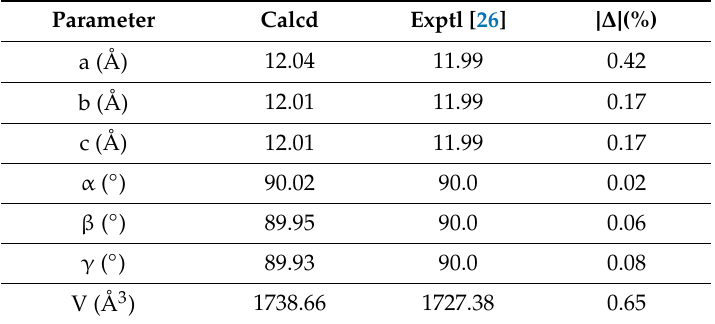
Table 2. Comparison between the experimental and calculated structural parameters of cubic ( I43 d ) C12A7:O 2 −